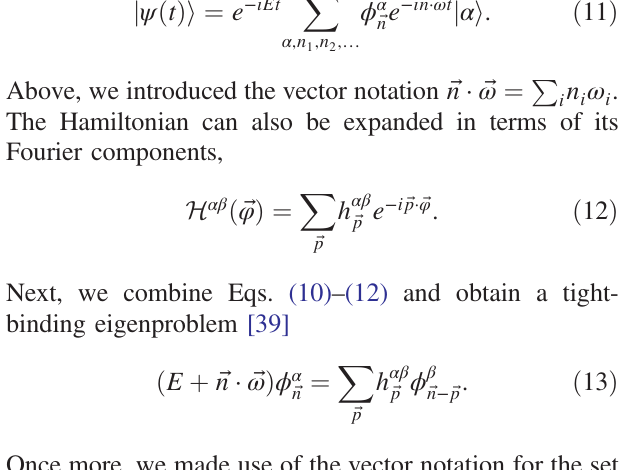
FIG. 2. The Floquet harmonics in a two-drive system give rise to a two-dimensional space. Each spot represents the n 1 ω 1 þ ⃗ n · ⃗ ω harmonic. If the frequencies are incommensurate, ω n 2 2 ¼ then the space is infinite. If the ratio ω 1 = ω 2 is rational, however, the infinite lattice contracts to a cylinder (strip marked in red, with periodic boundary conditions across the strip). The periodic drives appear to exert a force in the ⃗ n space along the ⃗ ω direction. The motion that arises because of Berry curvature is normal to the force and is indicated by the d ⃗ n=dt